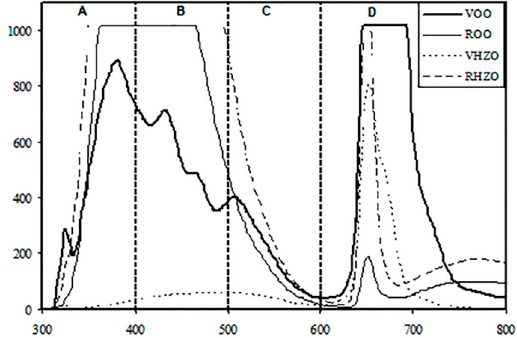
Figure 1. Characteristic luminescent spectra of virgin olive oil, virgin hazelnut oil, refined olive oil and refined hazelnut oil.